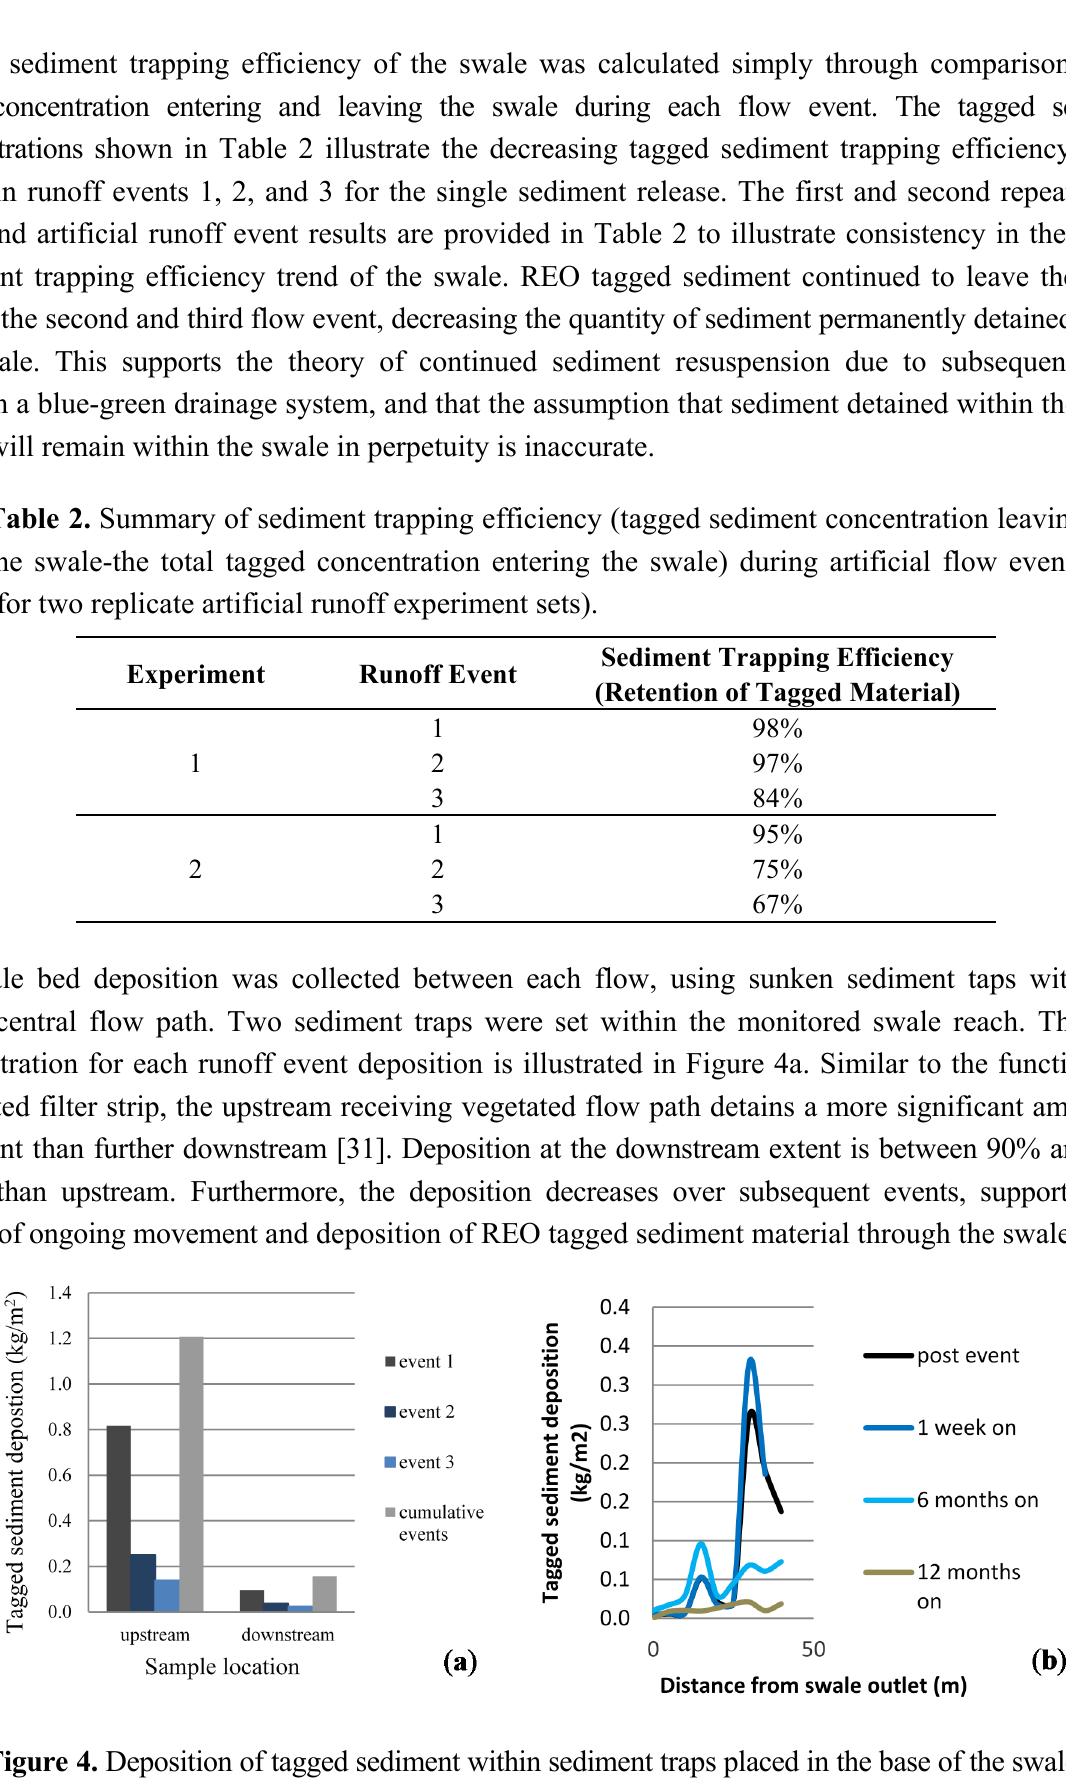
Figure 4. Deposition of tagged sediment within sediment traps placed in the base of the swale: within the swale between runoff events ( a ); and over the following 12-month period ( b